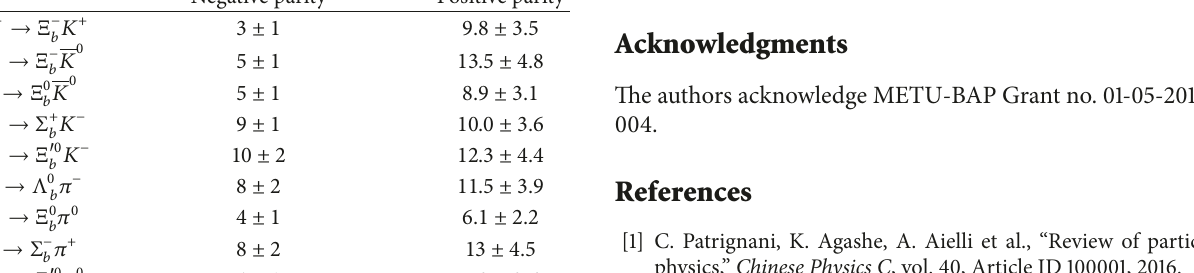
Figure 3: The same as in Figure 1, but for Ξ 0 𝑐 → Λ + 𝑐 𝐾 − transition.